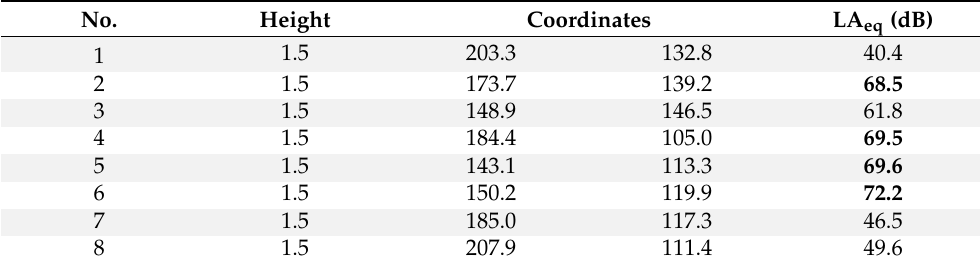
Table 8. Table of calculated values of measured points for earthworks during the execution of connections in the investigated area, with the simultaneous deployment of machines.